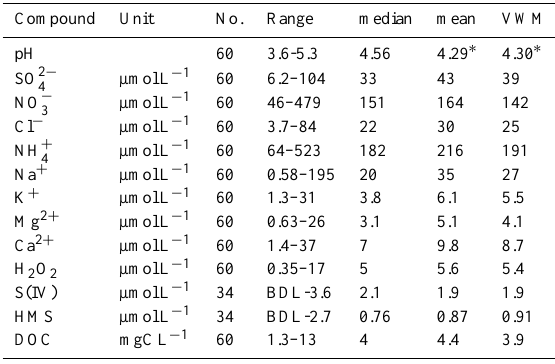
Table 2. Summary of cloud water solute concentrations determined during